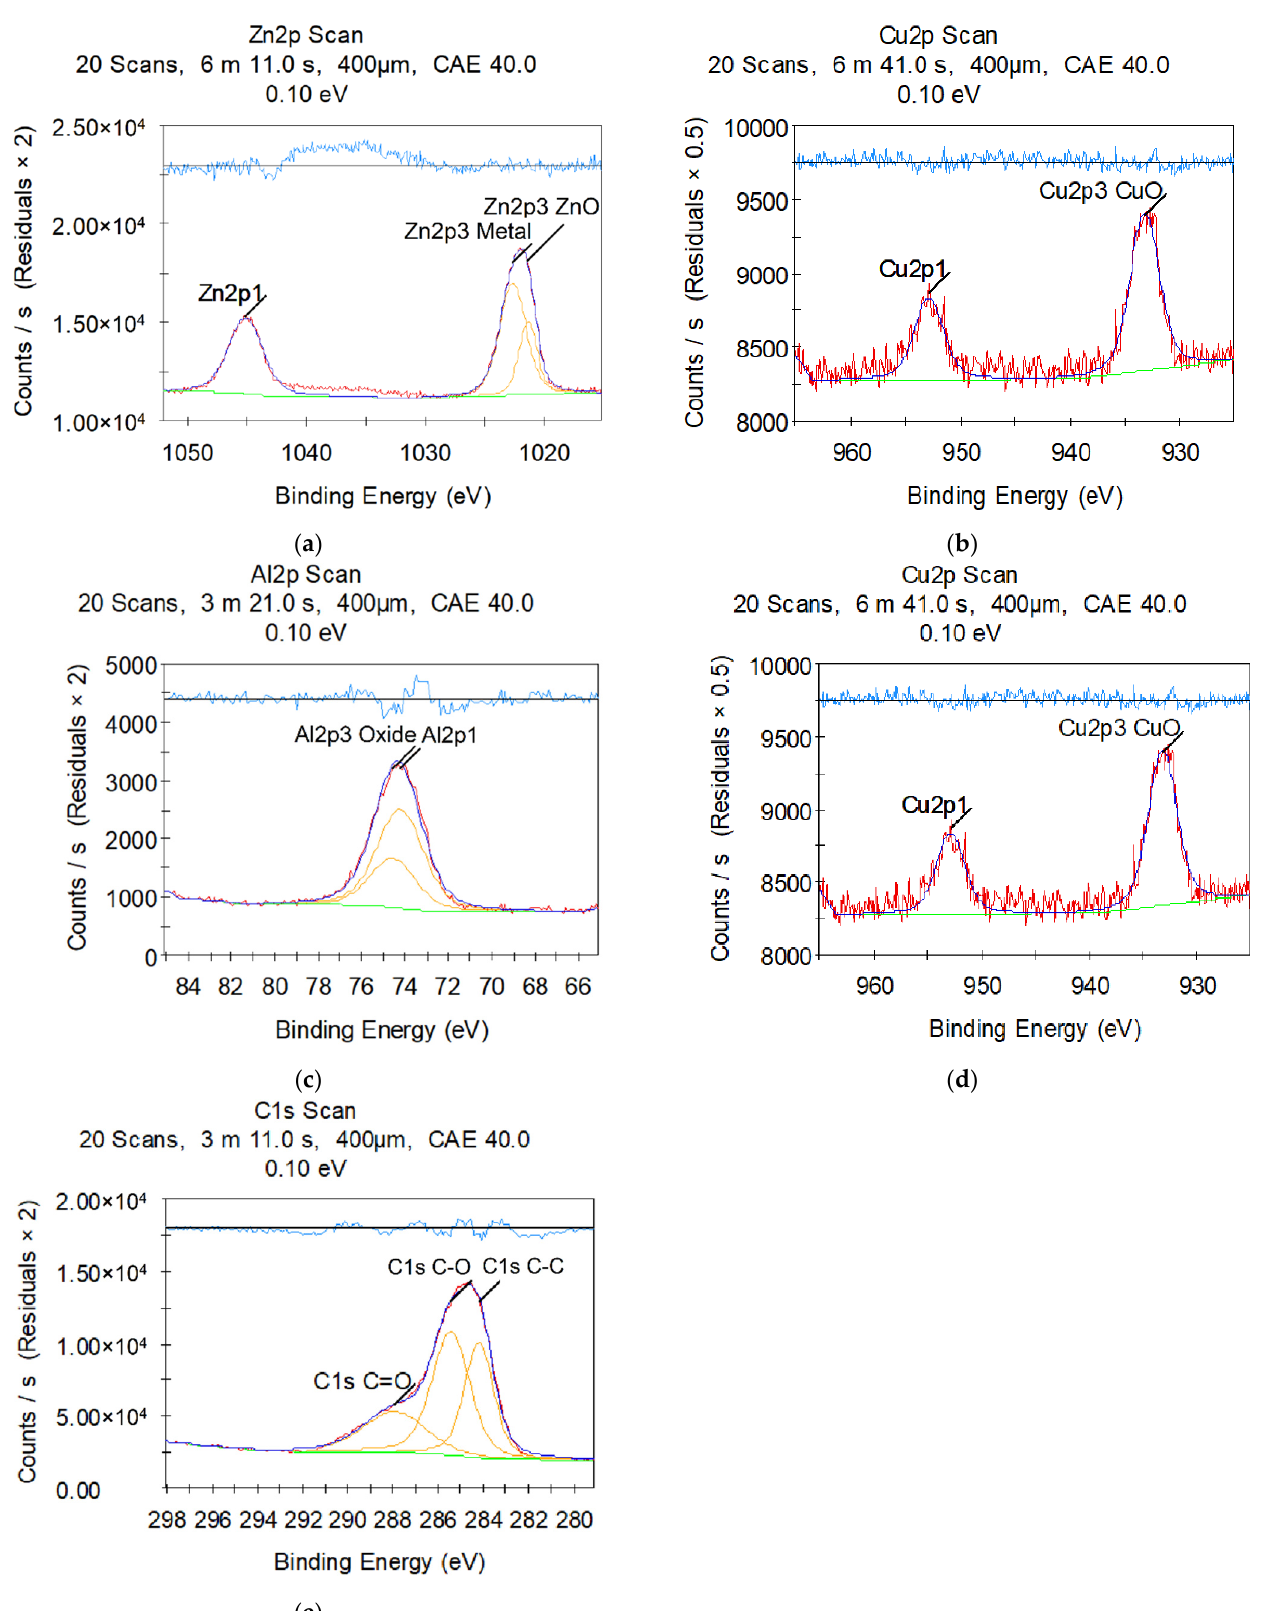
Figure 5. X-ray photoelectron spectroscopy of machined surfaces of 2024 (D16) duralumin workpiece in water medium: ( a ) zinc; ( b ) copper; ( c ) aluminum; ( d ) oxygen; ( e ) carbon.